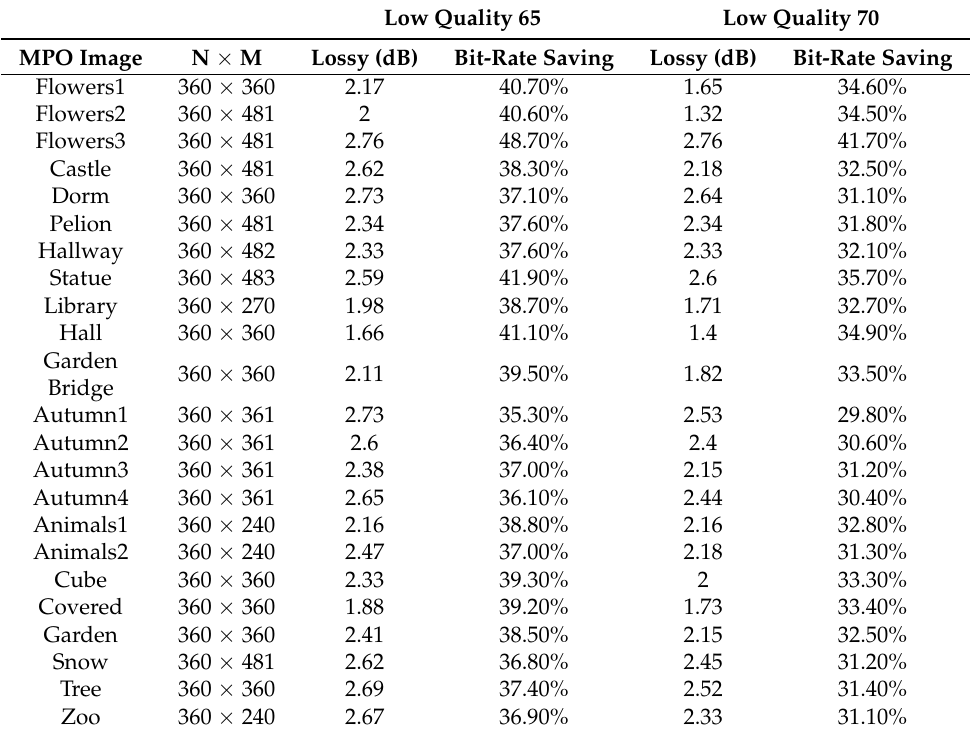
Table 1. Results obtained in the first experiments reported in